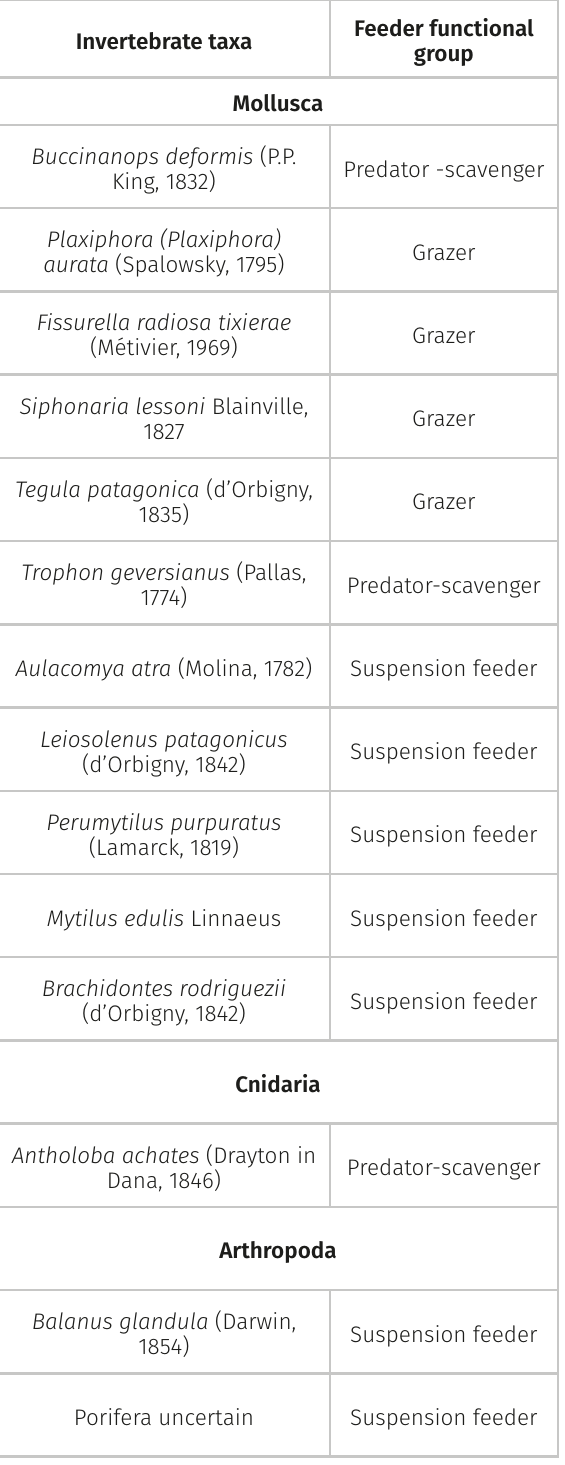
Table II. Invertebrate taxa assignments in term of feeder functional